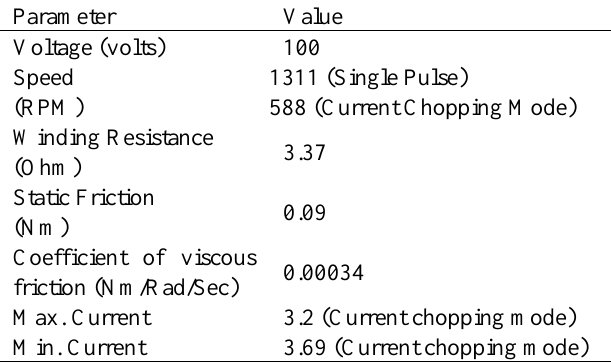
Motor Parameters considered for the three